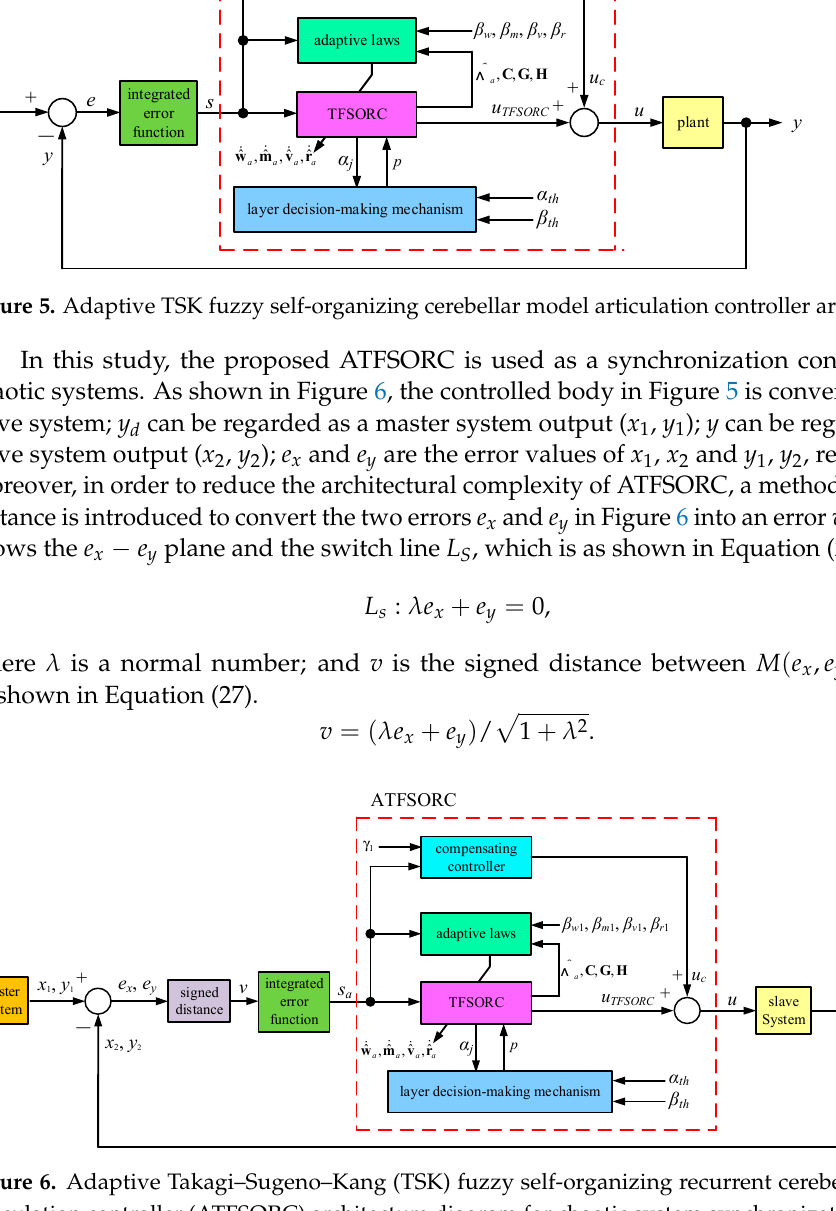
articulation controller (ATFSORC) architecture diagram for chaotic system synchronization.